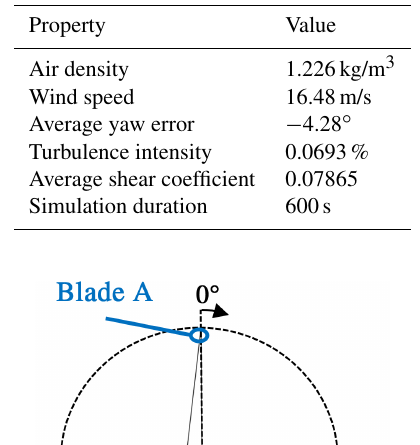
Table 1. Statistics of measured wind conditions as input for simu- lations.